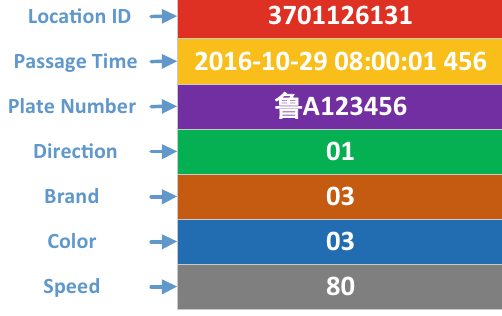
Fig. 1 Sliding window distributed monitoring architecture Fig. 2 Sample of traffic